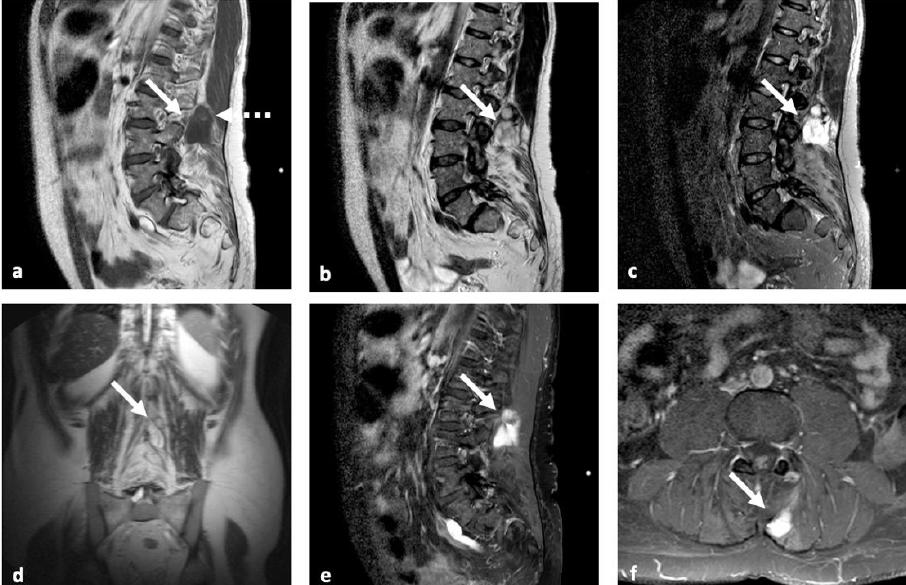
Figure 3. MRI examination—performed by sagittal T1-weight ( a ) and STIR ( c ) sequences, sagittal ( b ) and coronal ( d ) T2-weight, and sagittal ( e ) and axial ( f ) T1-weight contrast-enhanced sequences. The images confirm the presence of a grossly polylobate solid tissue (white arrows in ( a – f )) at level L2–L3 with sub-fascial extension to deep left paravertebral muscle site. This lesion presents a heterogeneous T1-w hypo-intensity with a spontaneous hyper-intensity underlying the presence of a fluid-fluid level (white dotted arrow in ( a )) due to hemoglobin degradation products. T2w and STIR sequences show heterogeneous hyper-intensity and inhomogeneous but avid post-contrast enhancement. These features are common in MPE metastasis.